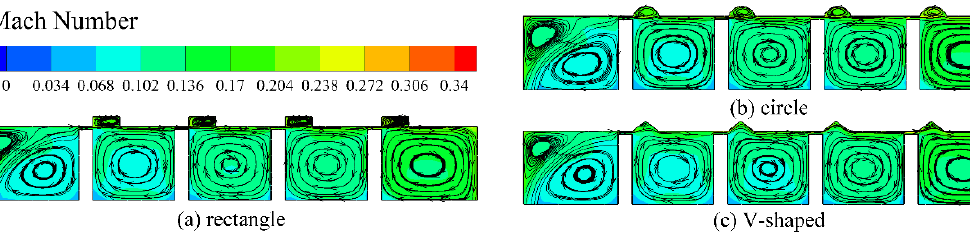
Figure 12. The Mach number contours of meridional plane of leakage passage on rotor.